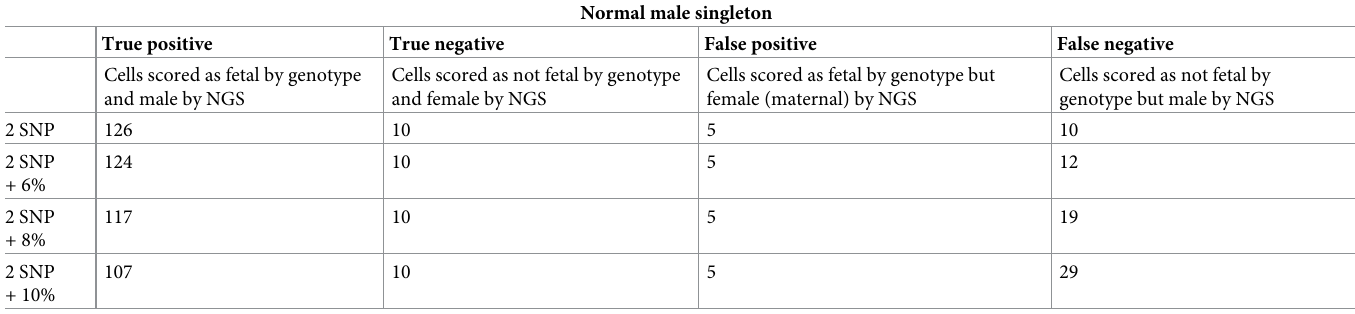
Table 3. Sensitivity and specificity for